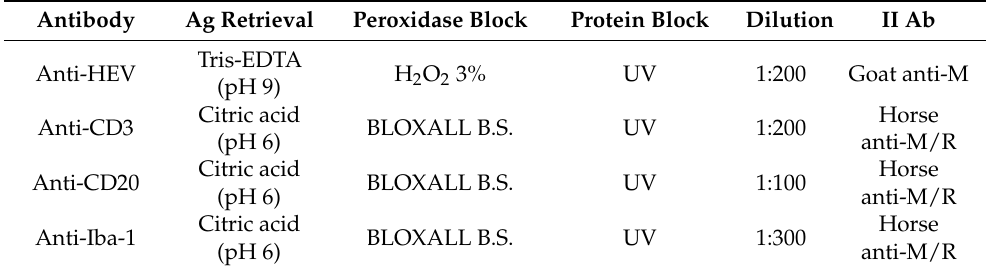
Table 1. Antibodies, reagents used for antigenic unmasking, blockade of endogenous enzymes and non-specific protein bonds, dilution of the primary antibody, and type of secondary antibody